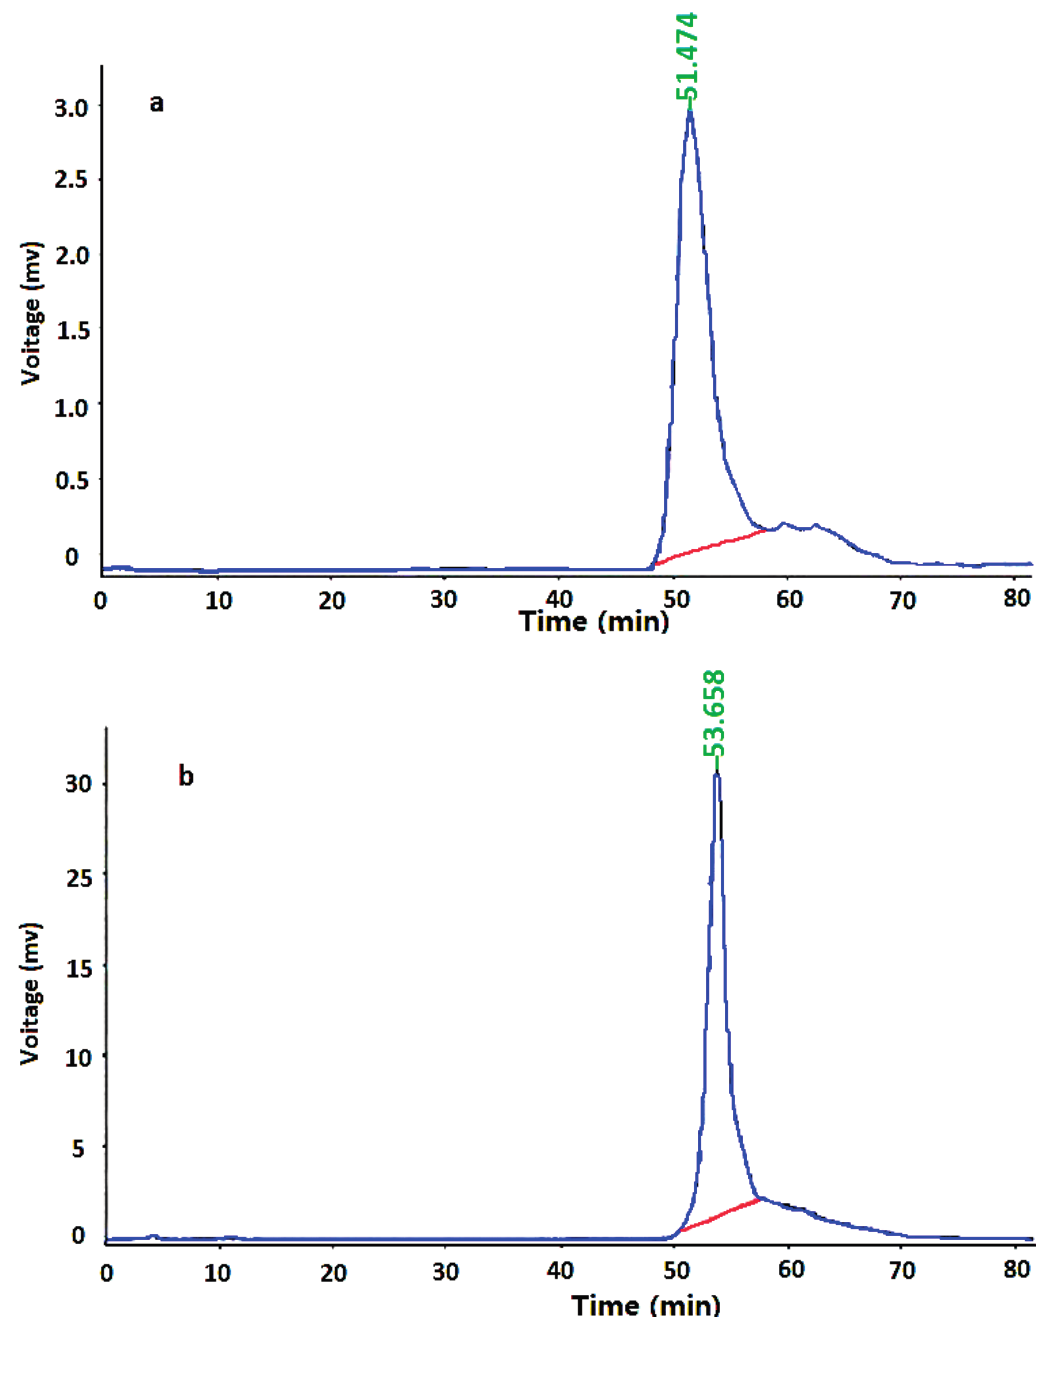
Figure 2. HPGPC chromatograms of ( a ) PEA-1and ( b ) PEA-2 of molecular